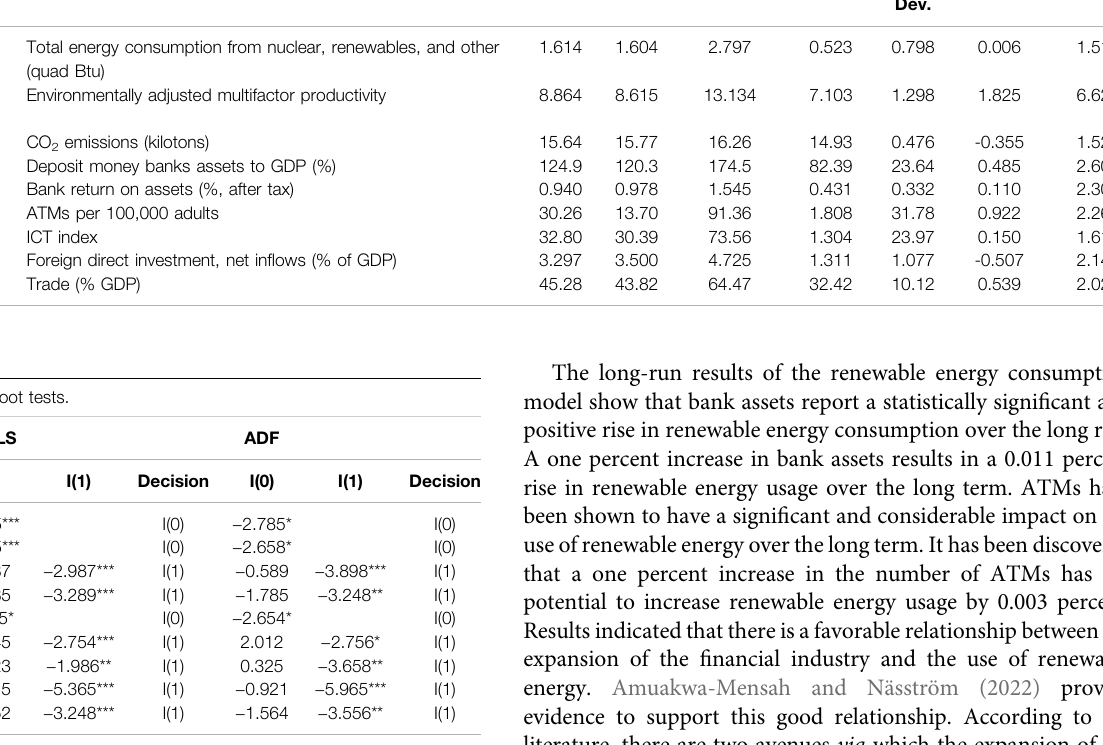
TABLE 1 | De fi nitions and descriptive statistics. Variables De fi nitions